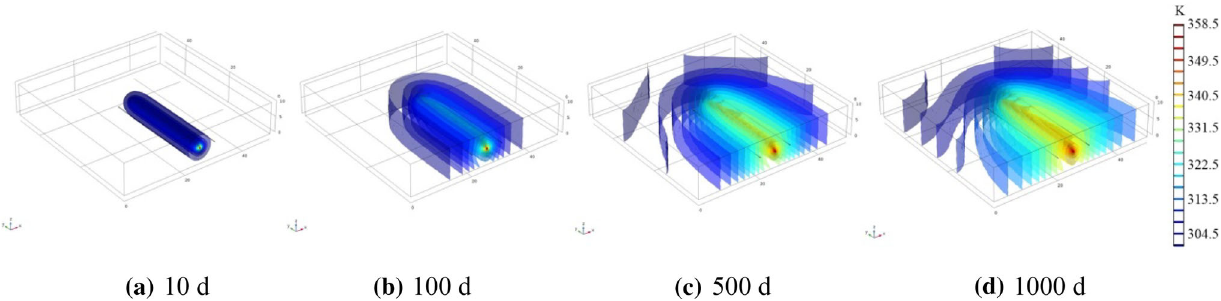
Fig. 4 Temperature distribution in the coal seam with heat injection temperature T z = 90 (cid:3) C